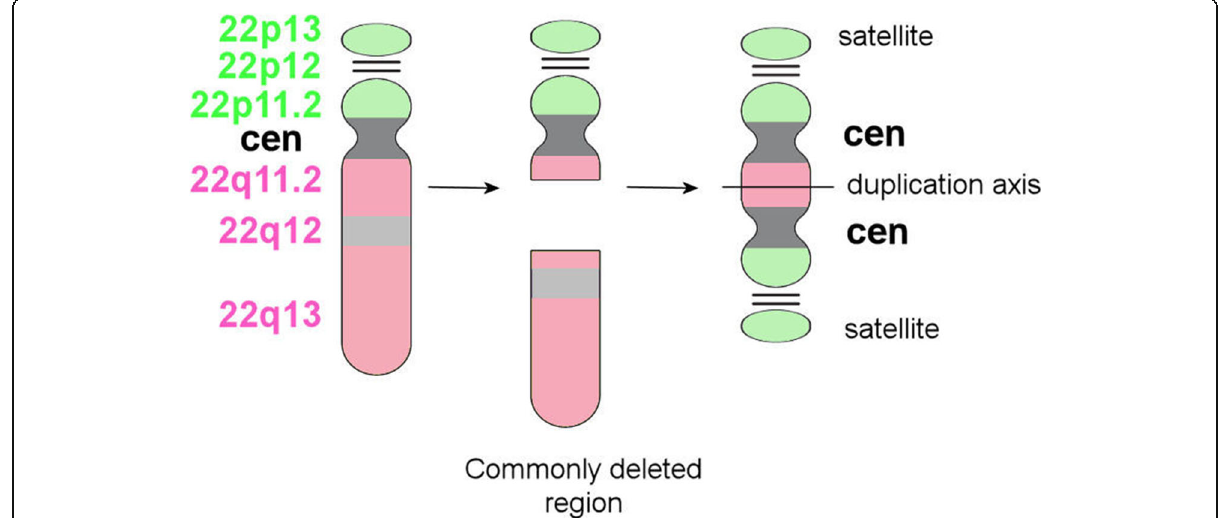
Fig. 2 The bisatellited and dicentric idic(22) formation scheme in a simplified outline. The acentric fragment is commonly